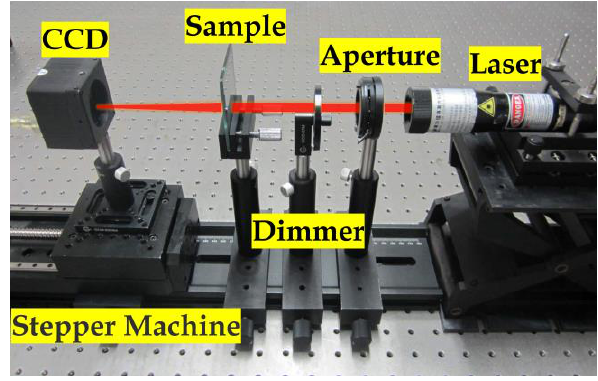
Figure 4. The experimental setup.